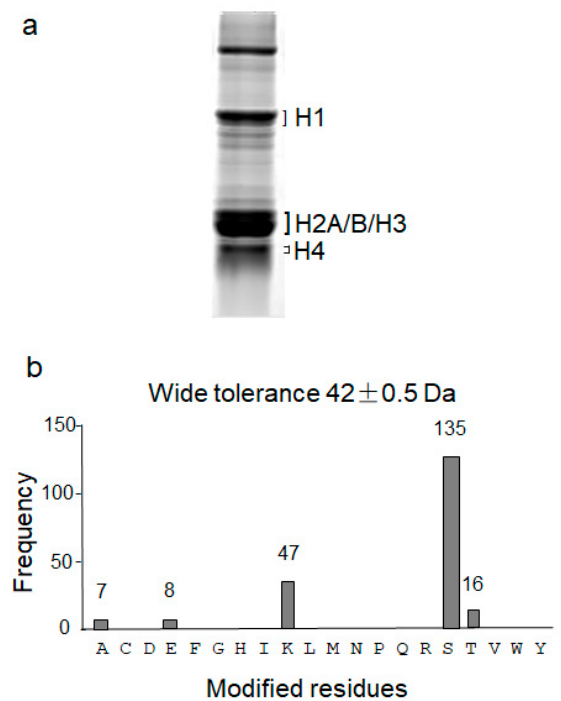
Figure 1. Wide tolerance acetylation (42 ± 0.5 Da) analysis at different amino acid residues of human histones. ( a ) Sodium dodecyl sulfate polyacrylamide gel electrophoresis (SDS-PAGE) of histone proteins from human kidney tissues. Histone proteins isolated from human kidney tissues were resolved by 12% SDS-PAGE and stained with Coomassie Brilliant Blue. The excised regions of the linker histone H1 and the core histones H2A/B/H3 and H4 were marked. ( b ) Frequency of wide tolerance acetylation (42 ± 0.5 Da). The acquired MS/MS spectra of histones were searched by a multi-blind spectral alignment algorithm (MODa) mimicking addition of 42 ± 0.5 Da delta mass on undefined amino acid residues against the human histone database. Frequency of the modified peptides at each amino acid was shown as indicated.